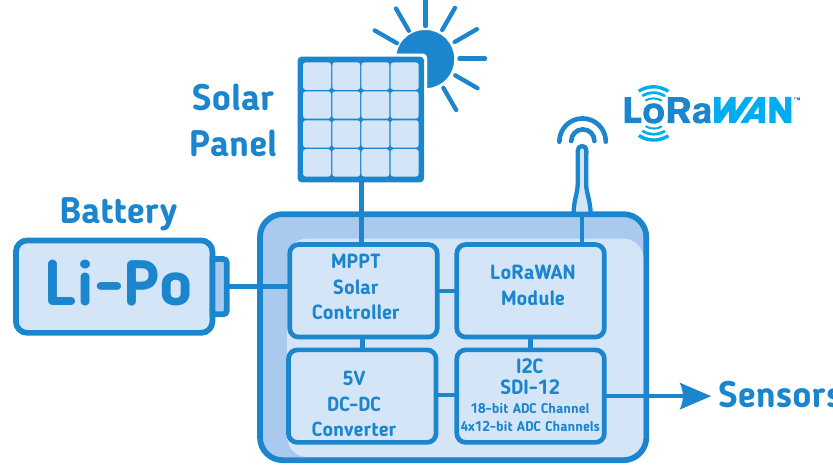
Figure 2. LoRaWAN system node